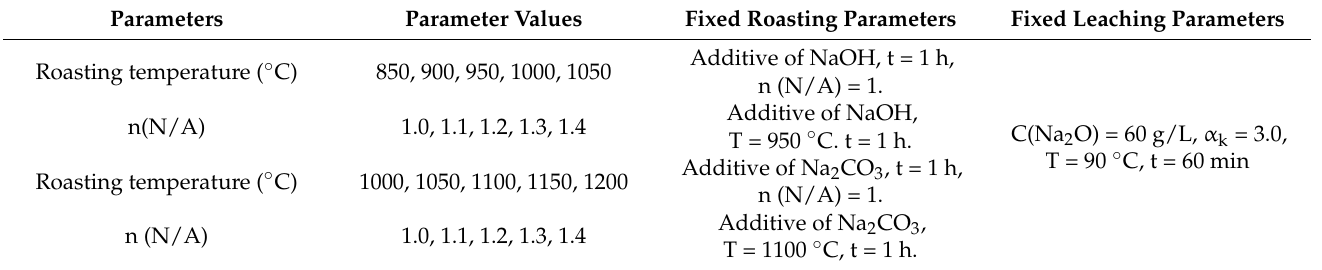
Table 2. List of roasting parameters studied in the